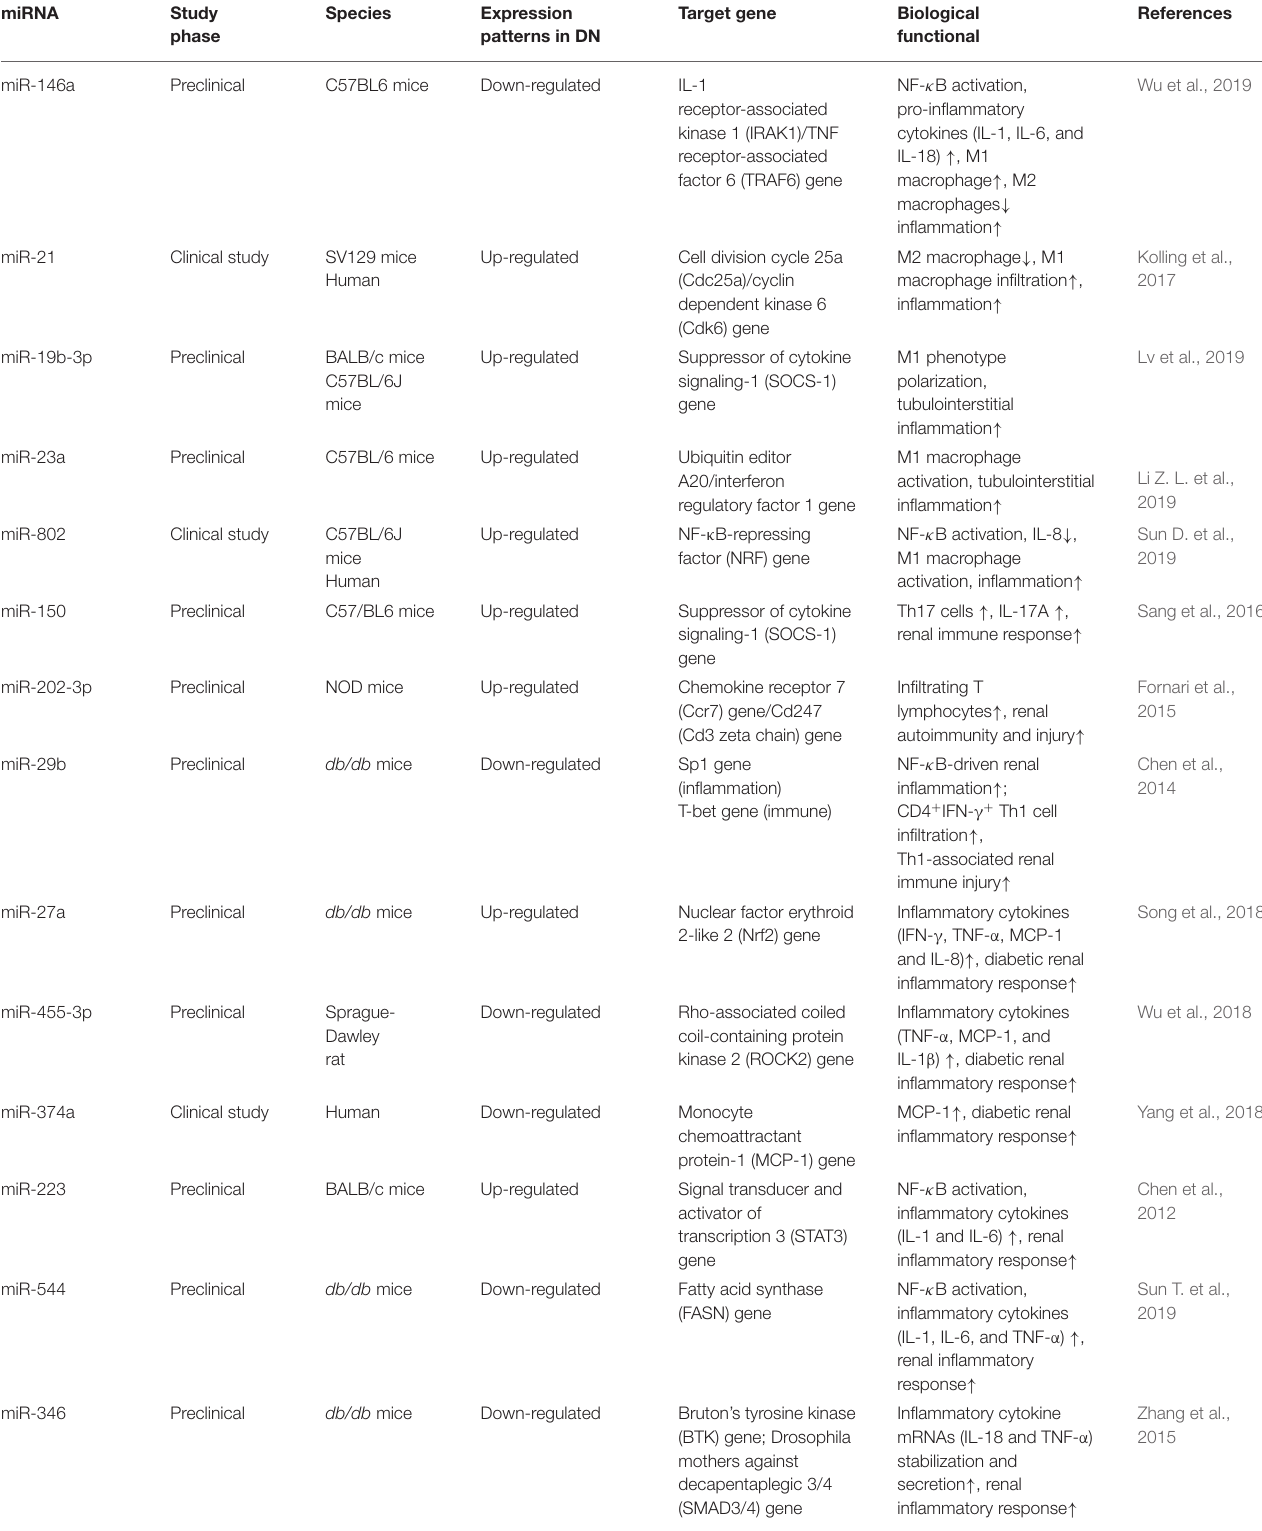
TABLE 1 | List of miRNAs involved in modulating the immune and inflammatory processes in diabetic nephropathy.